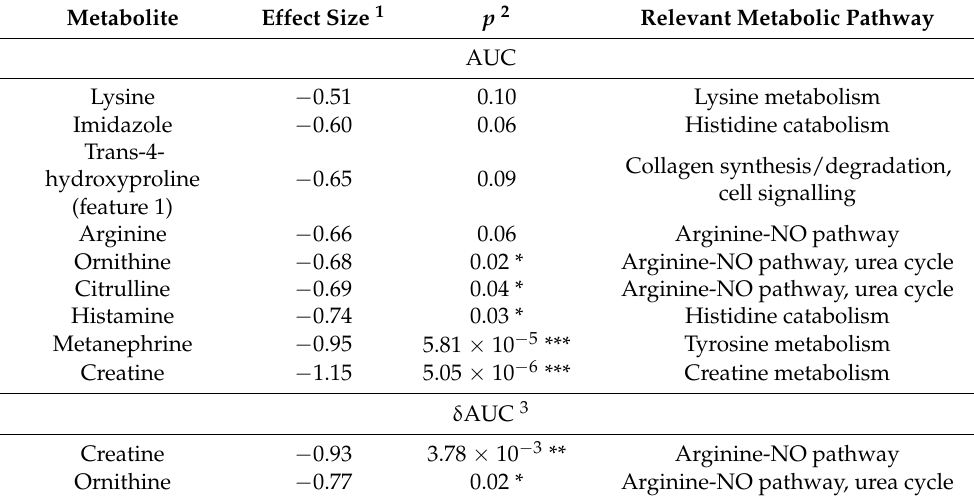
Table 2. Differences in AUC and δ AUC between high and low-GI.